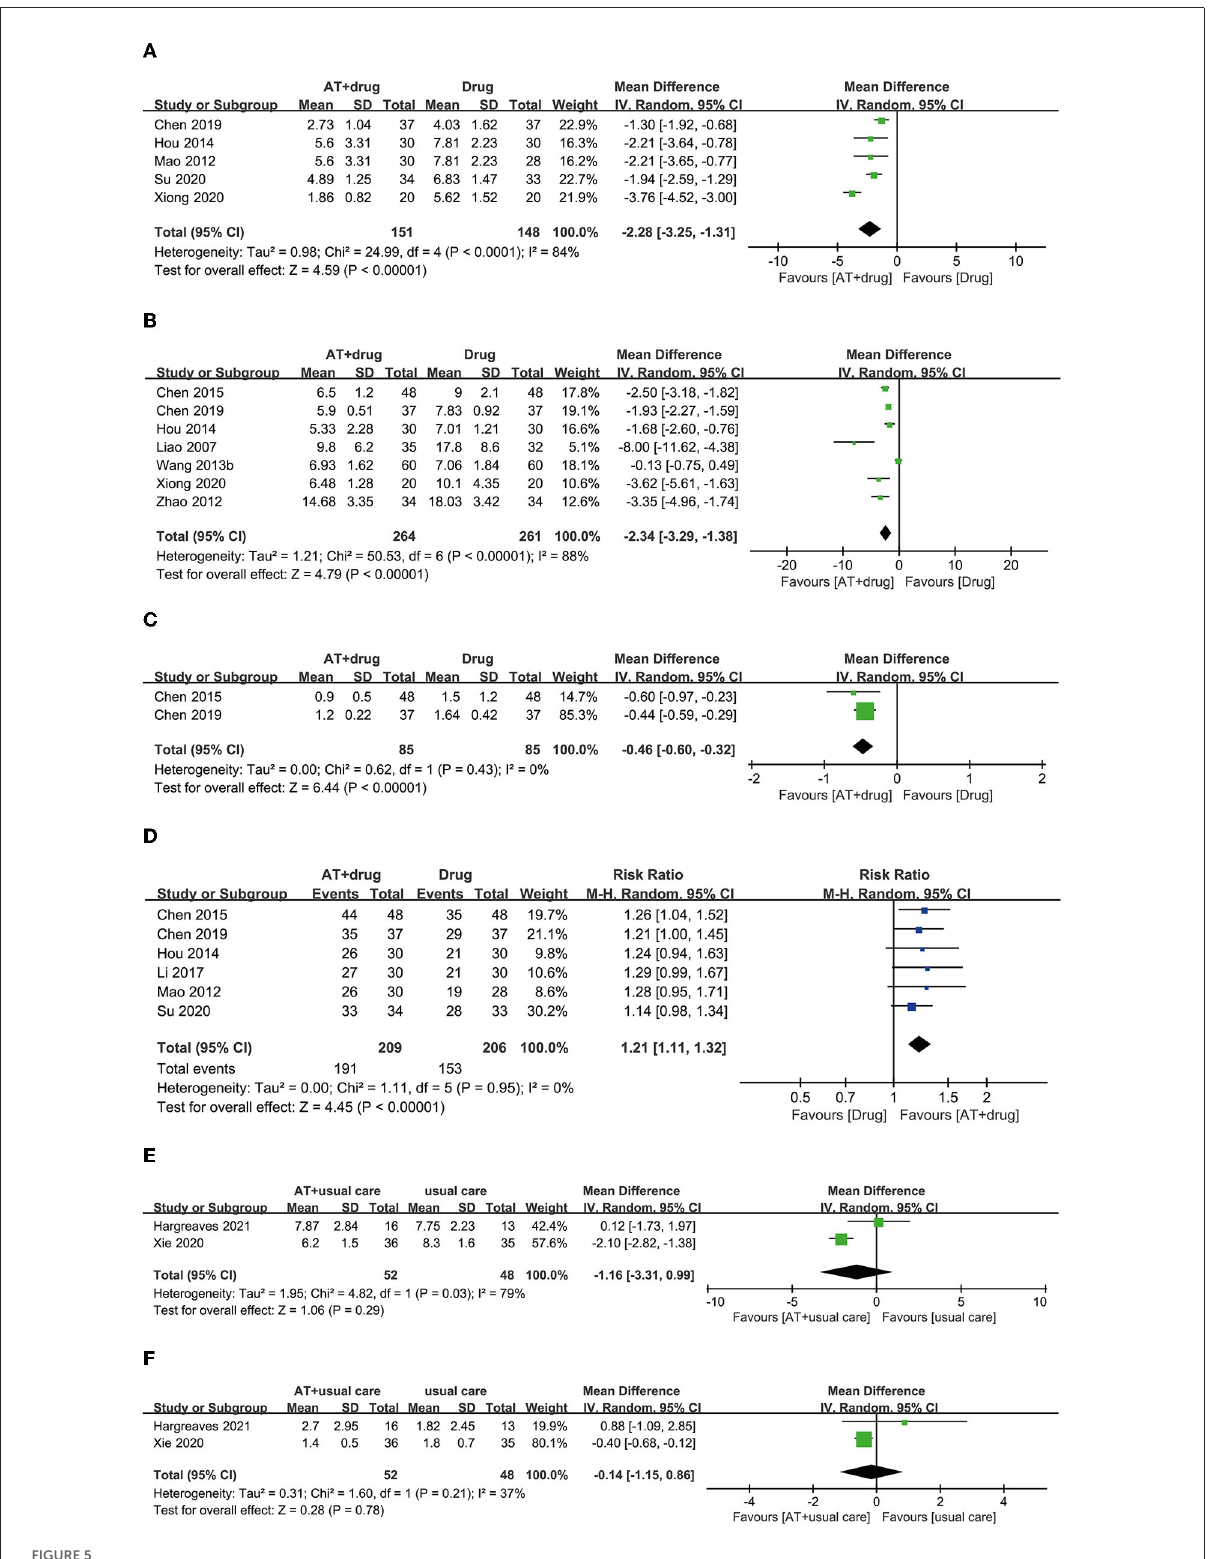
FIGURE5 Forest plot of (A) OABSS, (B) frequency, (C) incontinence, and (D) response rate according to the comparison of AT plus drug therapy vs. drug therapy. (E) Frequency, (F) incontinence according to the comparison of AT plus usual care vs. usual